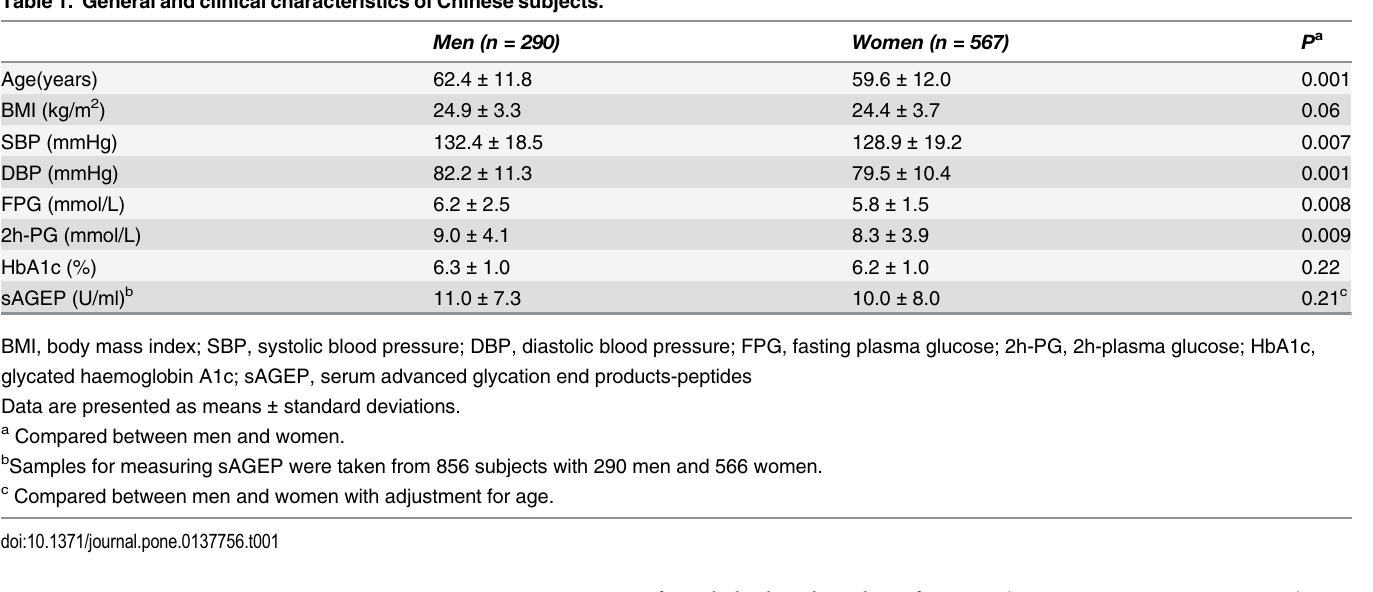
Table 1. General and clinical characteristics of Chinese subjects.